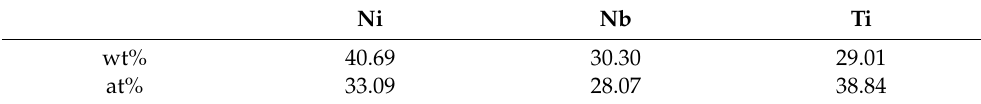
Figure 8. ( a ) Ni 33 Ti 39 Nb 28 ingot as removed from the crucible, ( b ) Ni 33 Ti 39 Nb 28 ingot after cutting. Table 2. Composition of the Ni-Nb-Ti sample (in wt% and at%). Table 2. Composition of the Ni-Nb-Ti sample (in wt% and at%). Table 2. Composition of the Ni-Nb-Ti sample (in wt% and at%).